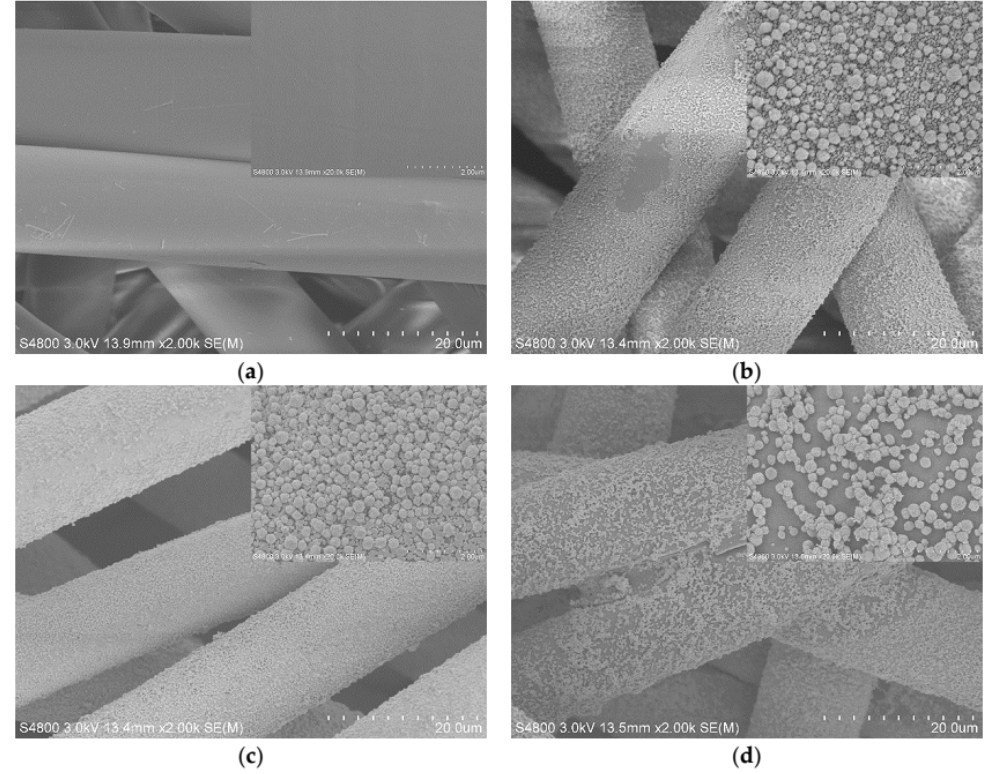
Figure 3. Scanning electron microscopy (SEM) images of ( a ) polyester nonwoven; ( b ) ZnO/Ag composite coated polyester nonwoven (3#); ( c ) ZnO/Ag composite coated polyester nonwoven (4#); and ( d ) ZnO/Ag composite coated polyester nonwoven